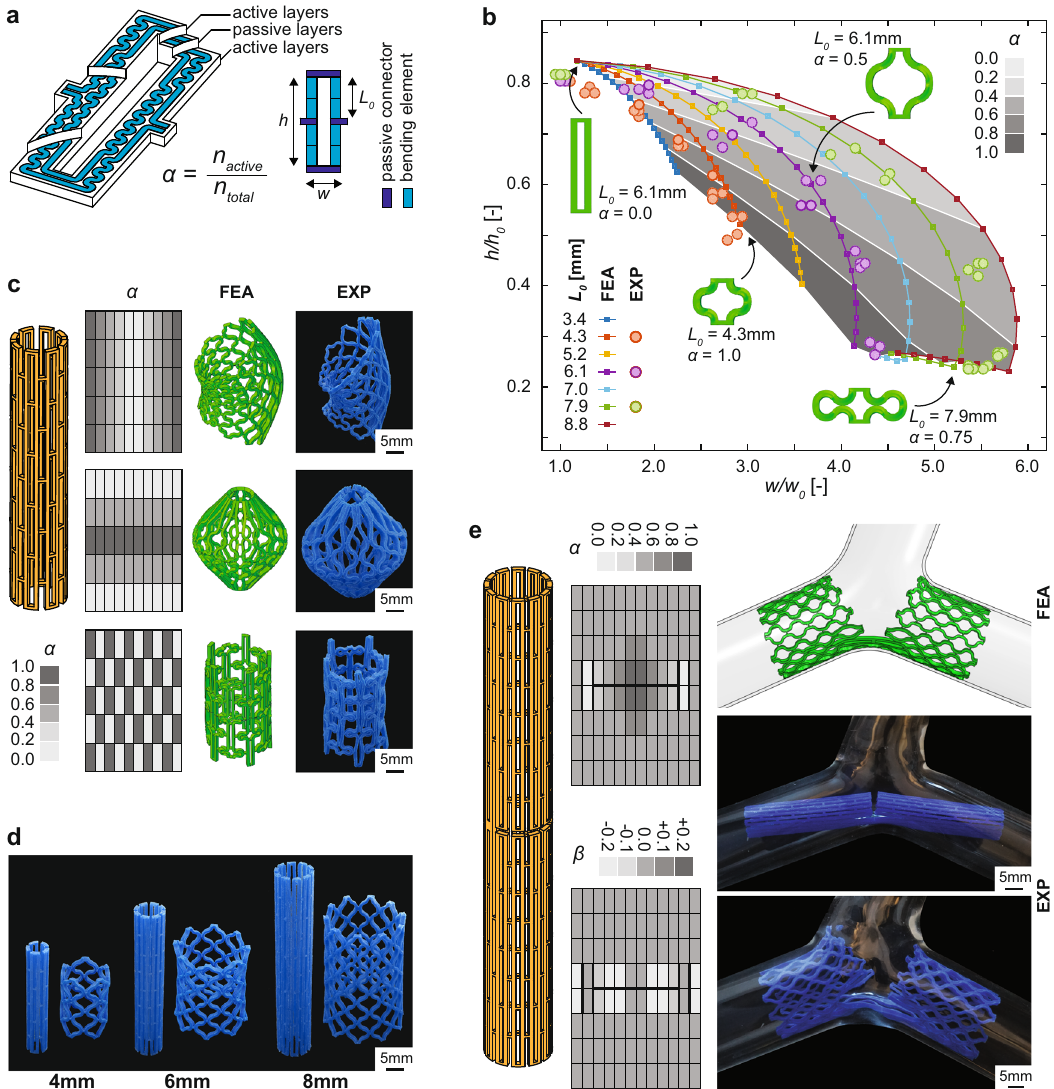
Fig. 4 Deployable materials and devices. a An illustration of the design strategy and printing path of a shape-shifting unit cell made of in-plane bending elements and passive connectors. b Computationally and experimentally obtained deformation characteristics of the expandable unit-cell. c Deployable cylinders made of different combinations of unit cells. d The dimensional scaling of the deployable stents. e The deployment of a bifurcation stent within a model artery. See Supplementary Videos 6,